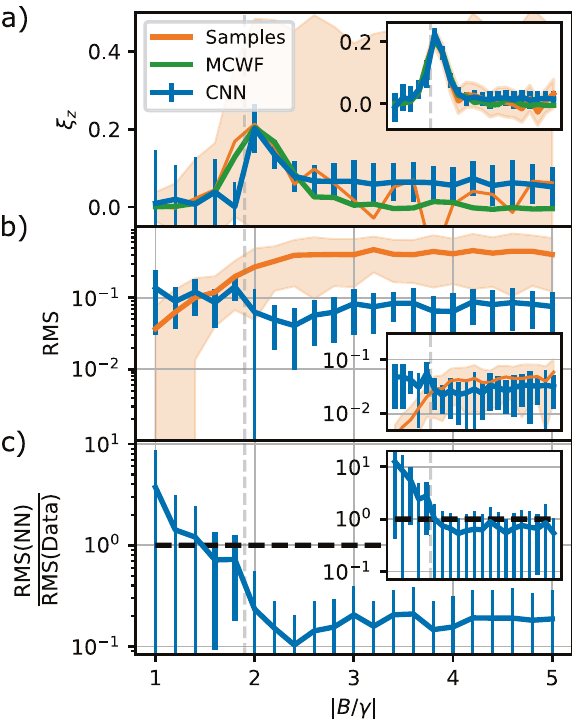
Fig. 5 Tomography of steady states: NN vs plain data. Dissipative phase transition of a 4 × 4 TFIM with spontaneous emission at J = − 1.25 γ with open boundaries. N s = 1 k (insets: 100 k). Gray vertical line: Switch ↑ and ↓ in POVM for CNN. a Observables according to Eq. (12) but summed only over system diagonal, b residual RMS error, c residual network RMS normalized to dataset RMS. Error bars are standard deviations across multiple independent tomography datasets and neural network training runs with randomly initialized